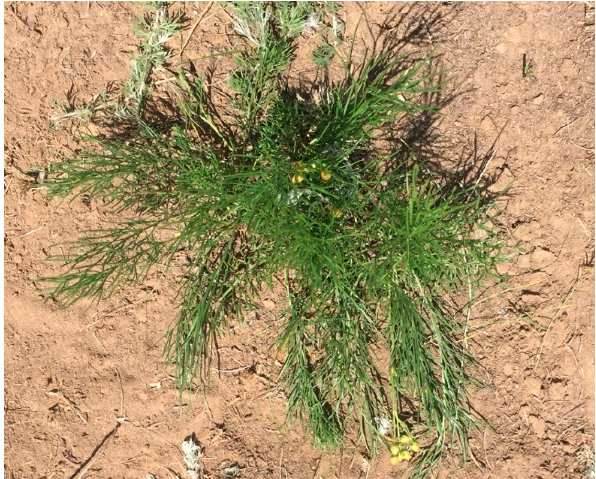
Figure 5. Photo of Artemisia subulata Nakai .